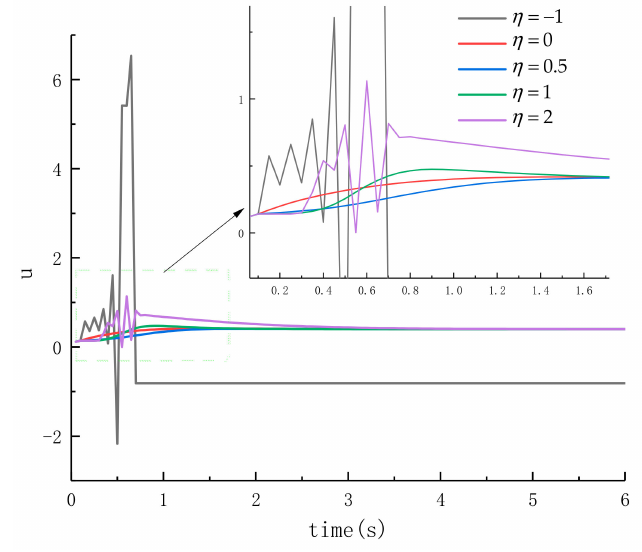
Figure 5. The effect of the value of η on the control